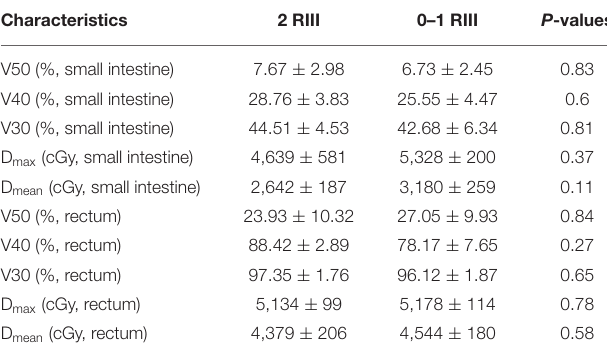
TABLE 3 | Dosimetric parameters of grade 2 and grade 0 or 1 RIII